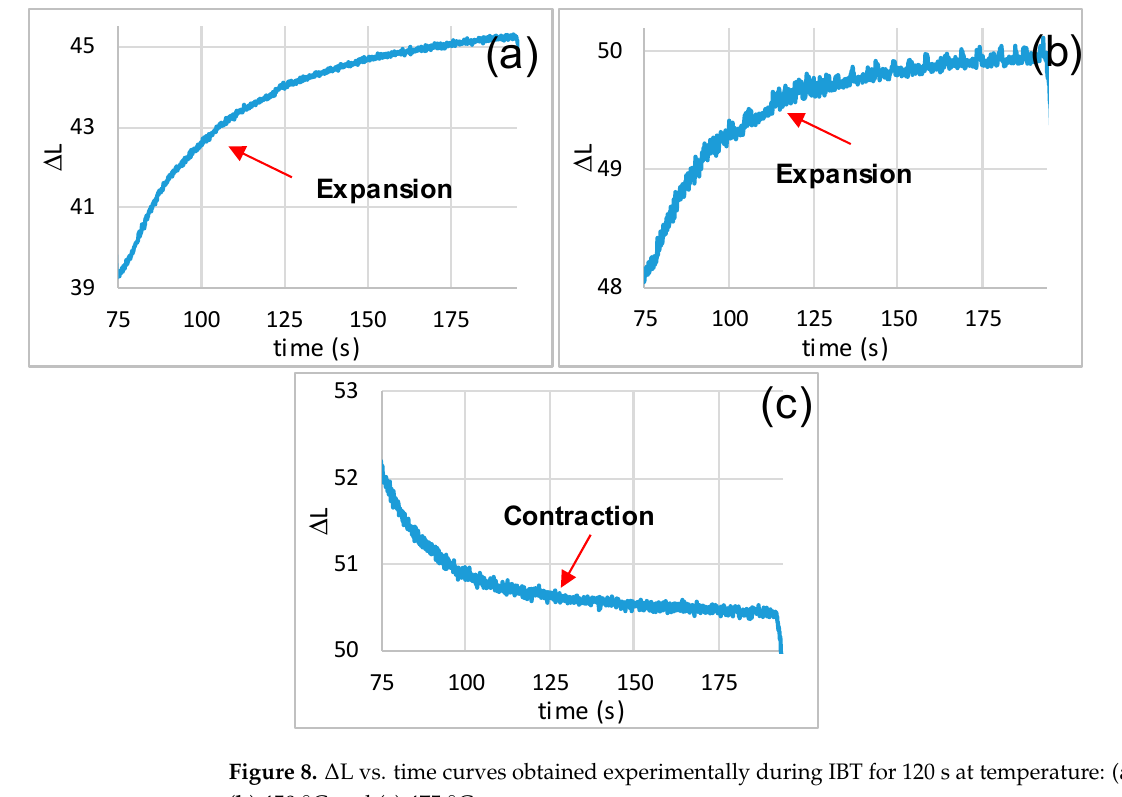
Figure 9. Temperature vs. time plots showing the variation of temperature during isothermal bainitic treatment conducted at: ( a ) 425 °C, ( b ) 450 °C, and ( c ) 475 °C.